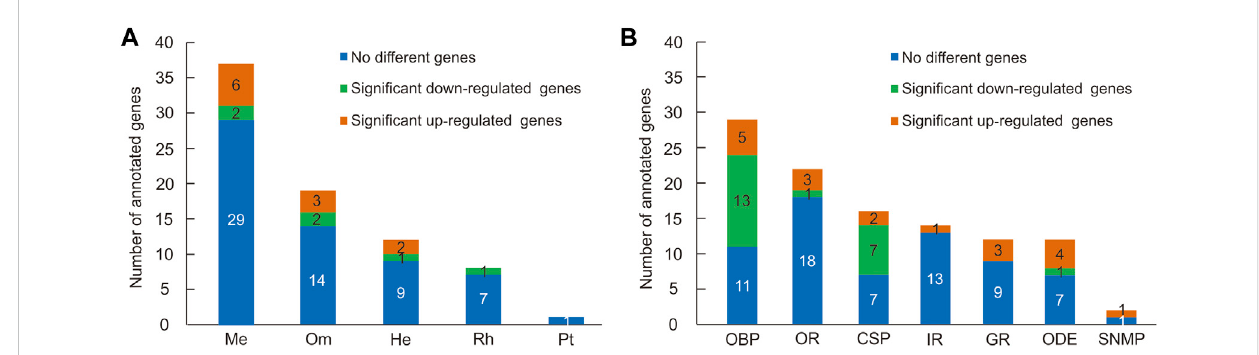
FIGURE 2 Numbers of pigment pathway and olfactory-related genes identi fi ed in the head and thorax transcriptomes of Gynaephora aureata . (A) Numbers of fi ve kinds of pigment pathway genes. Pigment pathway genes are abbreviated as follows: melanin-associated genes (Me), ommochrome-associated genes (Om), heme-associated genes (He), rhodopsin-associated genes (Rh), and pteridine-associated genes (Pt). (B) Numbers of seven kinds of olfactory-related genes.Olfactoryrelated genes are abbreviated as follows:odorant-bindingprotein(OBP), olfactory receptor(OR), chemosensory